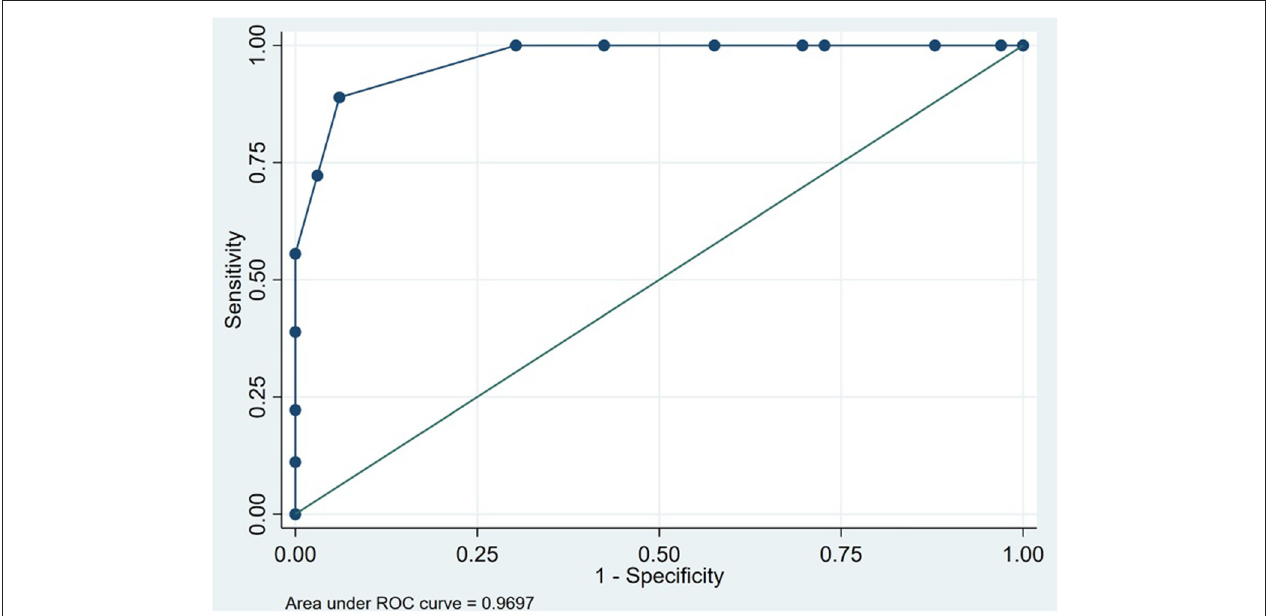
FIGURE 3 | Receiver operating characteristic curve for Interpersonal Reactivity Index, Perspective Taking subscale in 51 patients to discriminate between behavioral variant frontotemporal dementia and Alzheimer’s disease (Instituto Peruano de Neurociencias, Lima, Peru; 2017–2020).